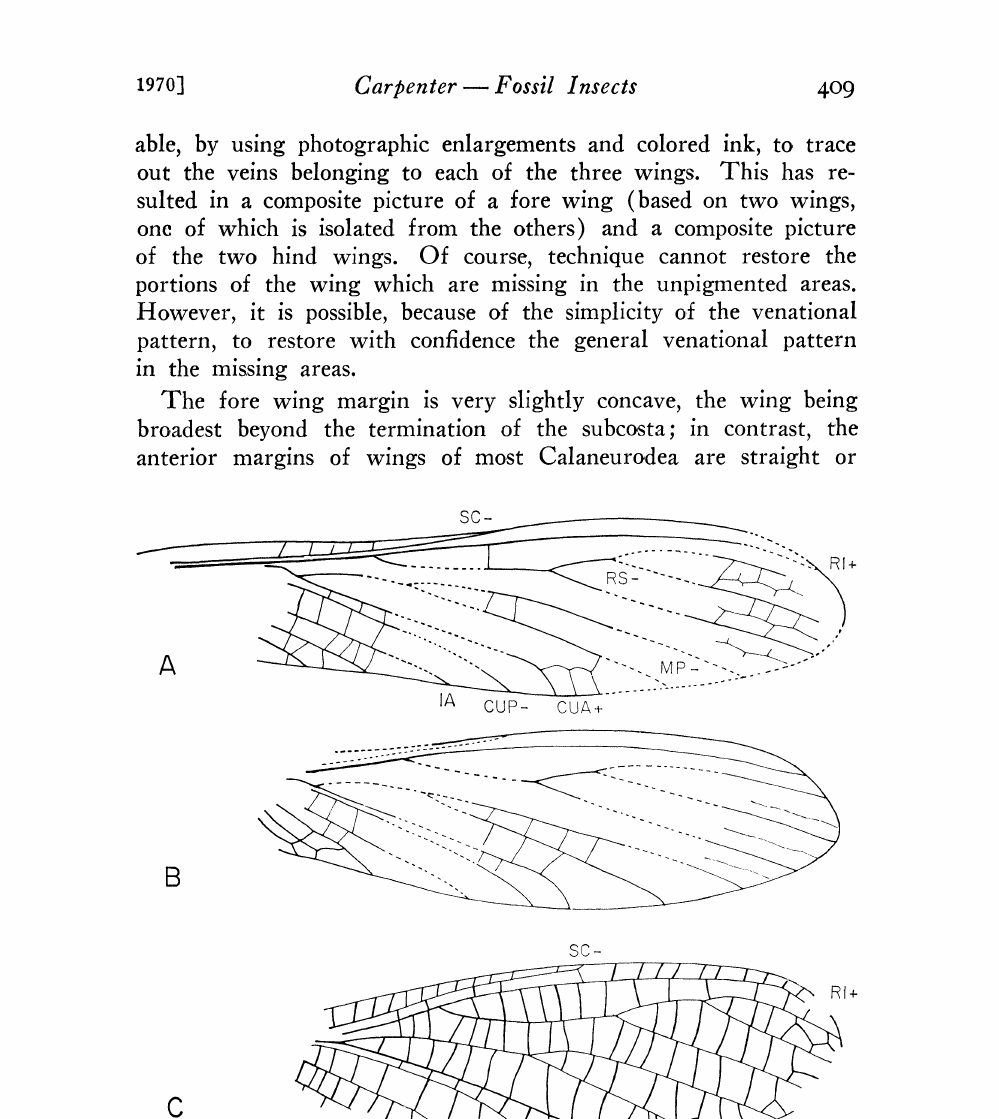
Fig. 6 (A) and (B) Permobiella [asciata, n.sp, drawing of fore (A) and hind (B) wings. (C) Permobiella ersicua Tillyard (Lower Permian of Kansas; original drawing based on type specimen, Peabody Museum, Yale Univer- sity and other specimens in the Museum of Comparative